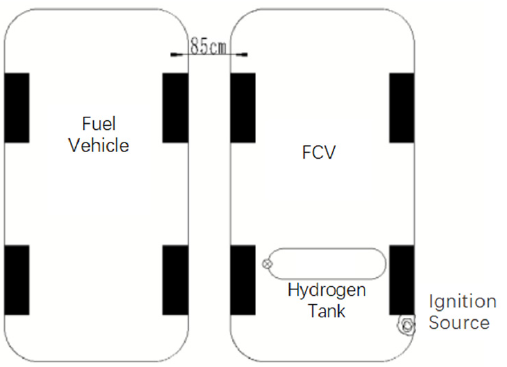
Figure 3. Fuel vehicle and hydrogen fuel cell vehicle stored side by side in a fire simulation.